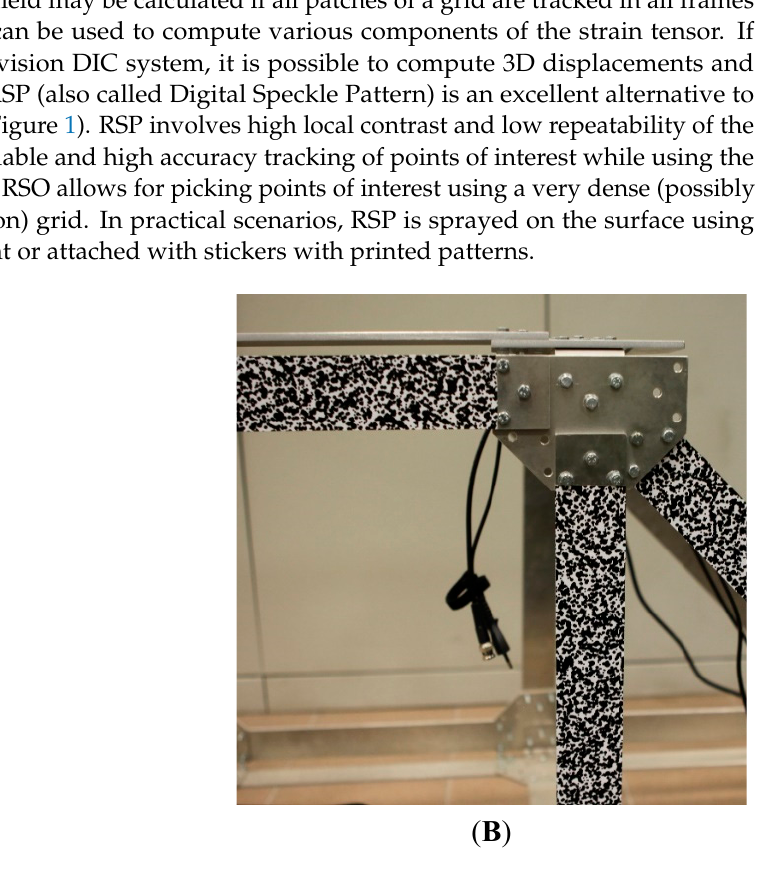
Figure 1. Structure prepared for vision measurements using vision markers ( A ) and RSP ( B ).